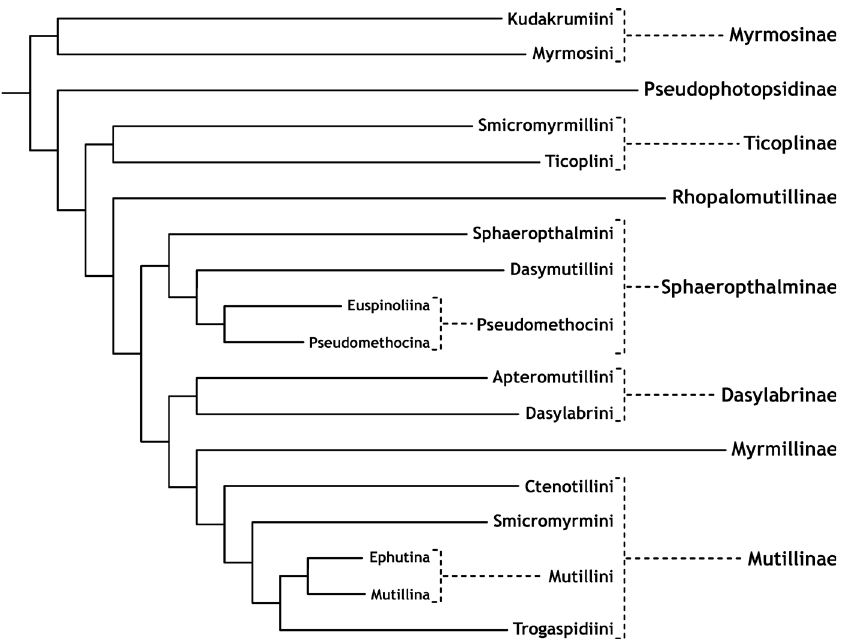
Figure 16. Final proposed higher classification of Mutillidae, as related to the rearranged tree (cf. Fig.